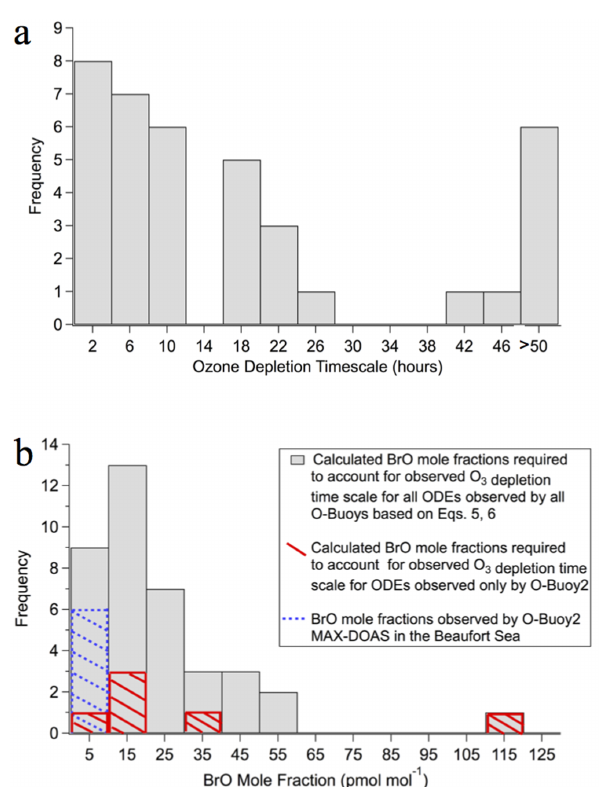
Figure 6. (a) Histogram of the calculated O 3 depletion timescale distribution during ODEs. To more clearly show the majority of events, the six events with τ O greater than 50h are grouped to- 3 gether on the histogram. (b) Calculated BrO concentrations are shown for the observed ODEs. These values were calculated using Eq. (6) with an assumed ClO mole fraction of 6pmolmol − 1 and other O 3 destruction pathways (discussed in Sect. 3.1). The calcu- lated BrO mole fraction mode is 15pmolmol − 1 . Measured BrO for O-Buoy2 is shown as the blue hatched bar, and the corresponding BrO required to account for the observed ozone depletion rates for O-Buoy2 events are shown as solid red diagonal